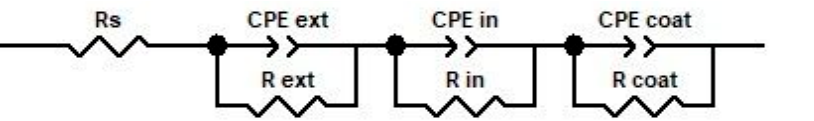
Figure 8. Electrical equivalent circuits proposed for fitting the experimental impedance spectra for the CrN x -coated 310 H SS samples.